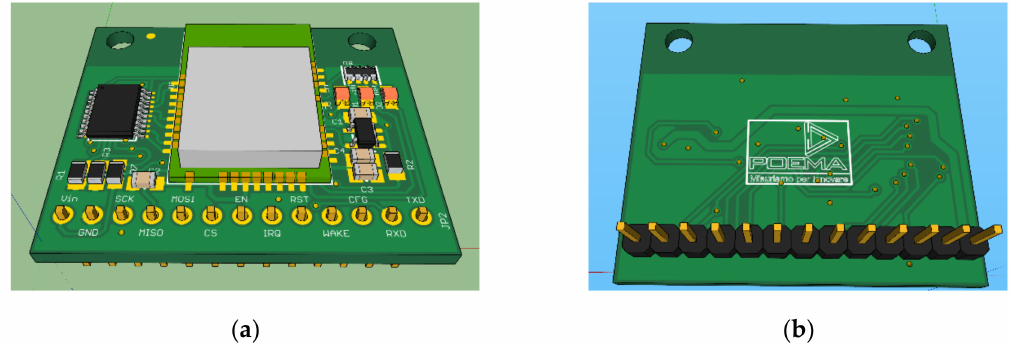
Figure 5. A 3D view of the Wi-Fi module: ( a ) front side; ( b ) back side.